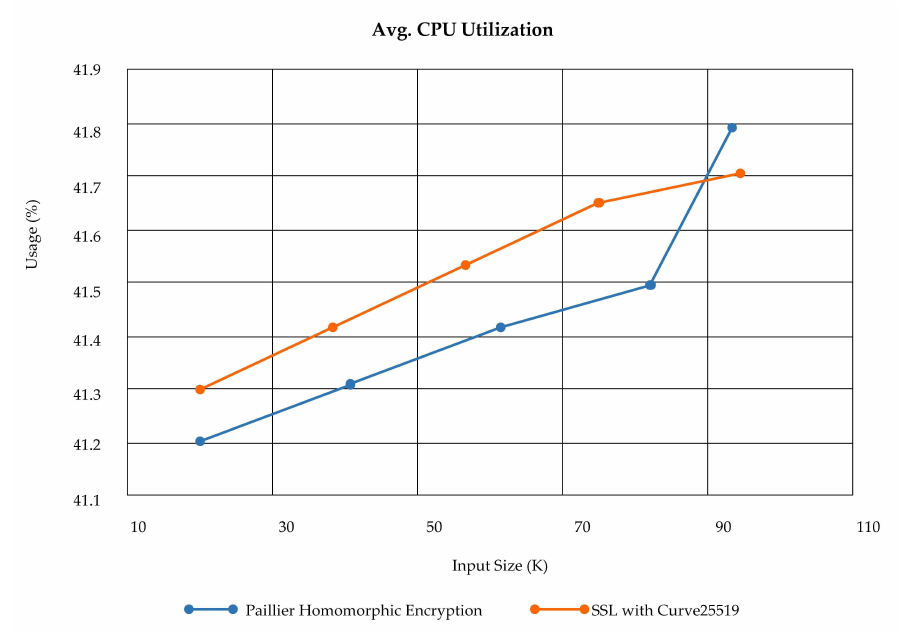
Figure 22. Average CPU utilization for secure log storage using